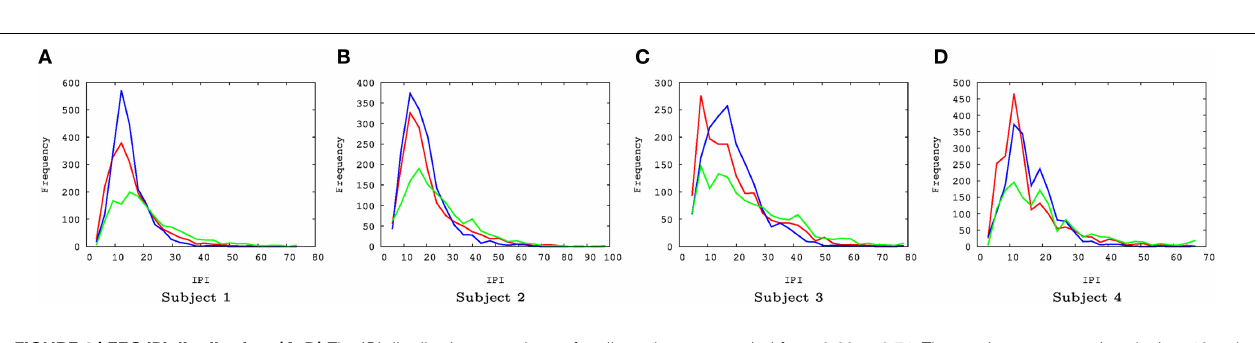
FIGURE 6 | EEG IPI distribution. (A–D) The IPI distributions are shown for all four subjects, for all three conditions (awake [red], REM [blue], and SWS [green]). For all cases, the IPI distributions are positively skewed. The